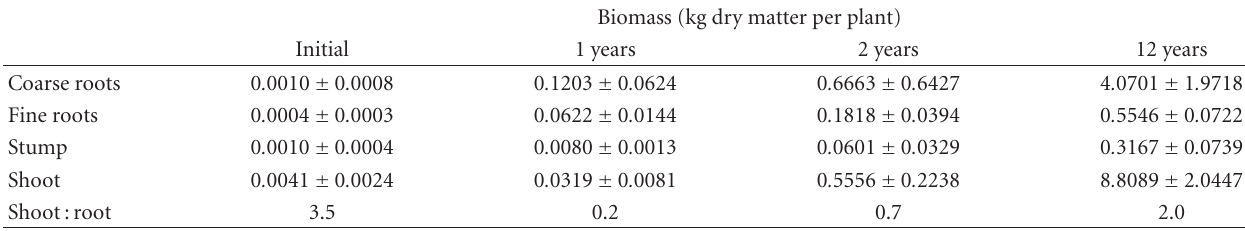
Table 2: Average biomass per plant compartment and shoot:root ratio calculated as (shoot + stump)/(fine roots + coarse roots) for di ff erent plant ages of Robinia pseudoacacia (standard deviation is given as error).